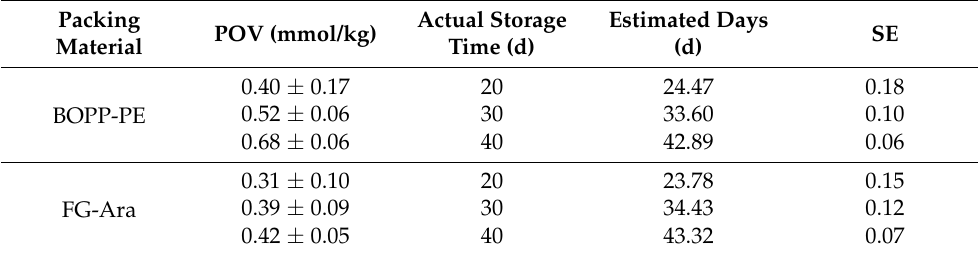
Table 8. Validation results under natural